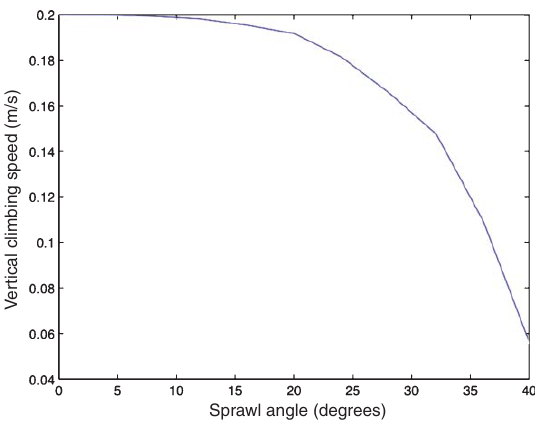
Fig. 9. Steady-state vertical climbing velocity plotted versus sprawl angle for the world-switched muscle-powered climber. Despite being tuned at a sprawl angle of 12 ◦ , a sprawl angle of 0 ◦ maximizes vertical climbing speed.